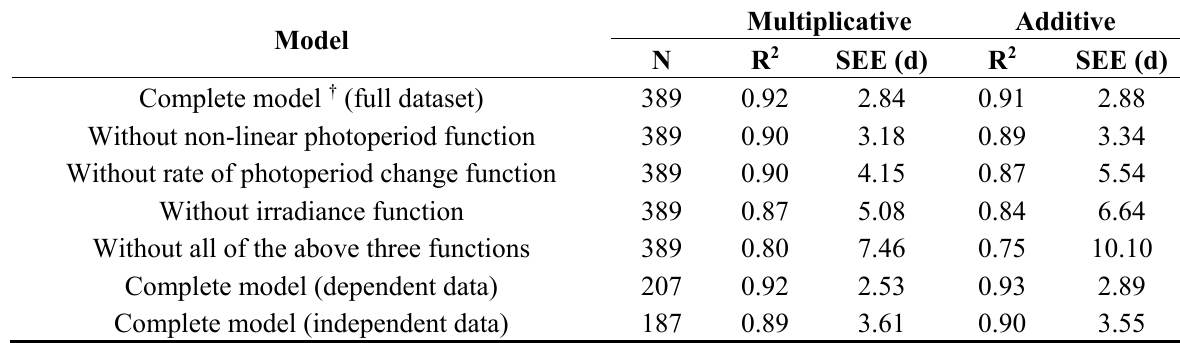
Table 2. Model standard errors of estimate (SEE) and R 2 for complete and reduced models for predicting time to first flower for soybean.